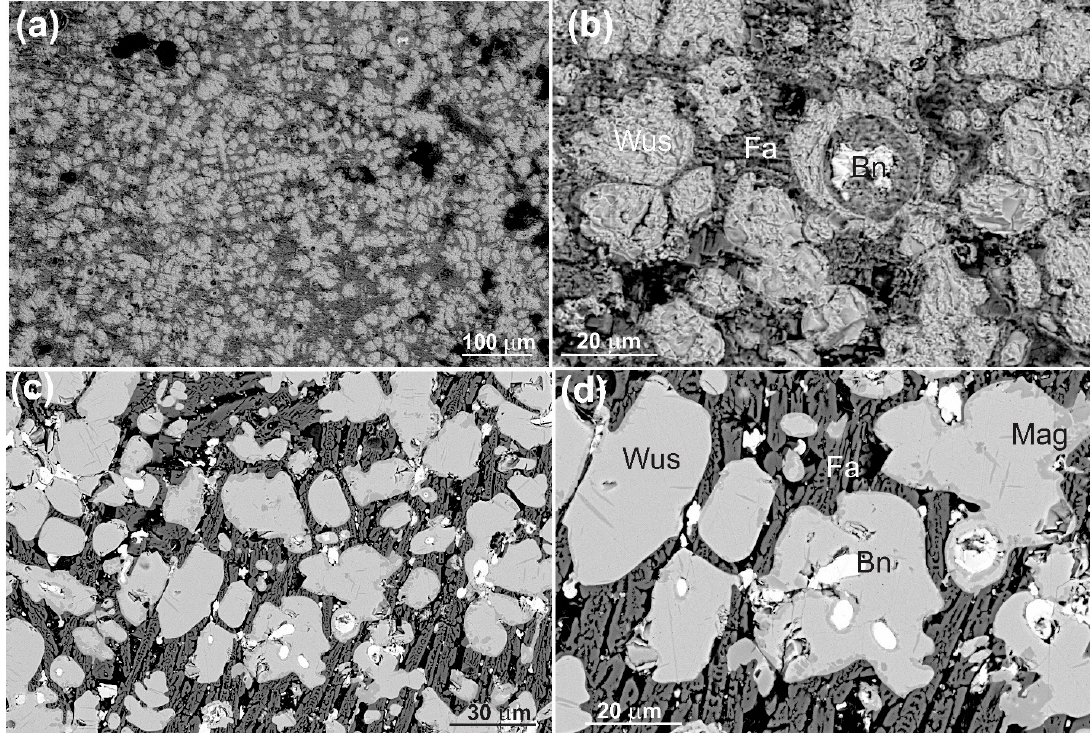
Figure 12. SEM-BSE images of magnetic slag. ( a ) Aggregations of wüstite (bright) in a fayalite matrix (dark). ( b ) Enlarged view of a region with wüstite (Wus) and fayalite (Fa) and some bornite (Bn) surrounded by fayalite. ( c ) Region with rounded wüstite/magnetite crystals (grey) and a skeletal fayalite matrix (dark). ( d ) Enlarged area of ( c ) with wüstite (Wus, brighter), magnetite (Mag, darker), some crystals with local bornite (Bn, white). Black is porosity. Images ( a , b ) were taken at variable vacuum, no carbon coat; ( c , d ) at high vacuum with carbon coat.